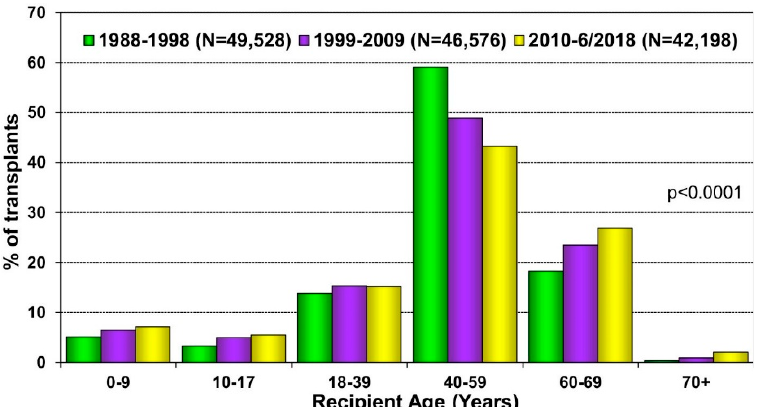
Figure 1. Recipient age distribution (adult and pediatric) by era. Reprinted with permission from Khush KK, Wida CS, Chambers DC, et al. The International Thoracic Organ Transplant Registry of the International Society for Heart and Lung Transplantation: Thirty-sixth adult heart transplantation report—2019; focus theme: Donor and recipient size match. J Heart Lung Transplant; 2019;38:1056–1066.